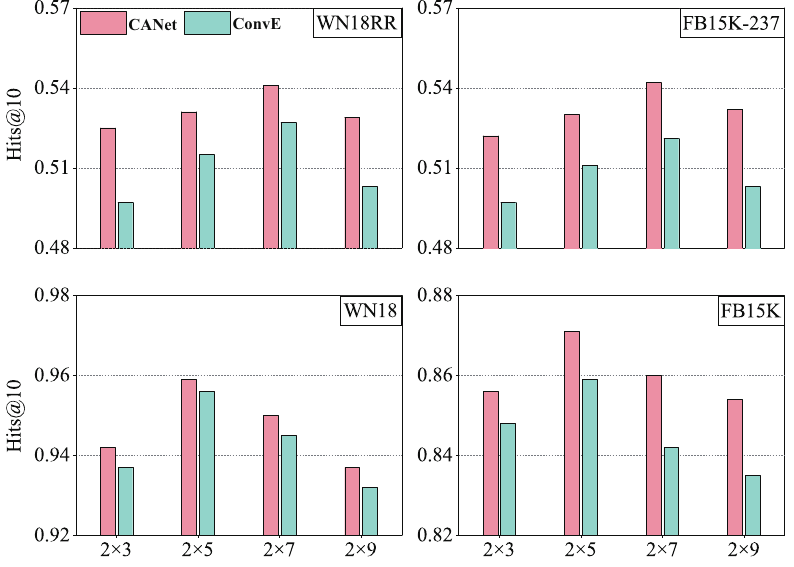
Figure 3. The Hits@10 performance with various kernel sizes on four